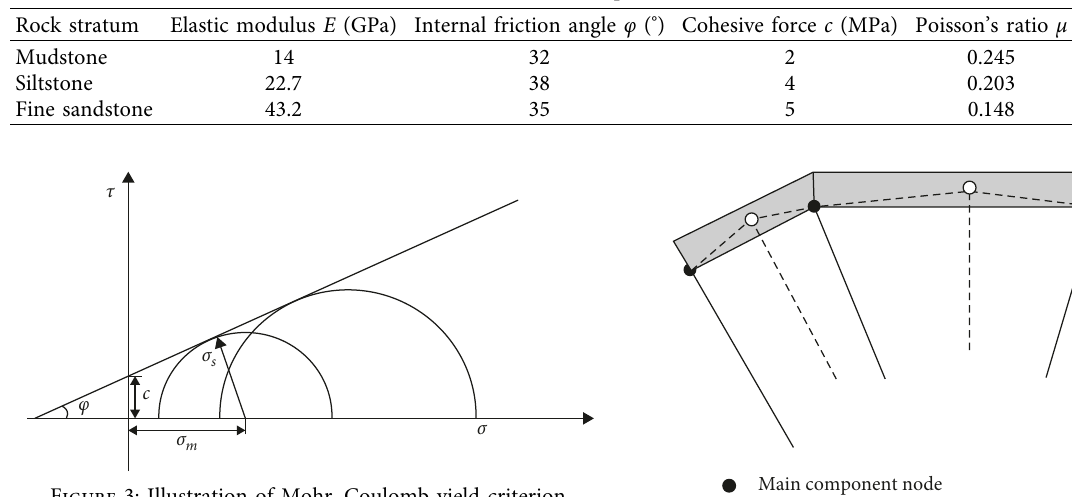
Table 1: Mechanical parameters of rock strata.